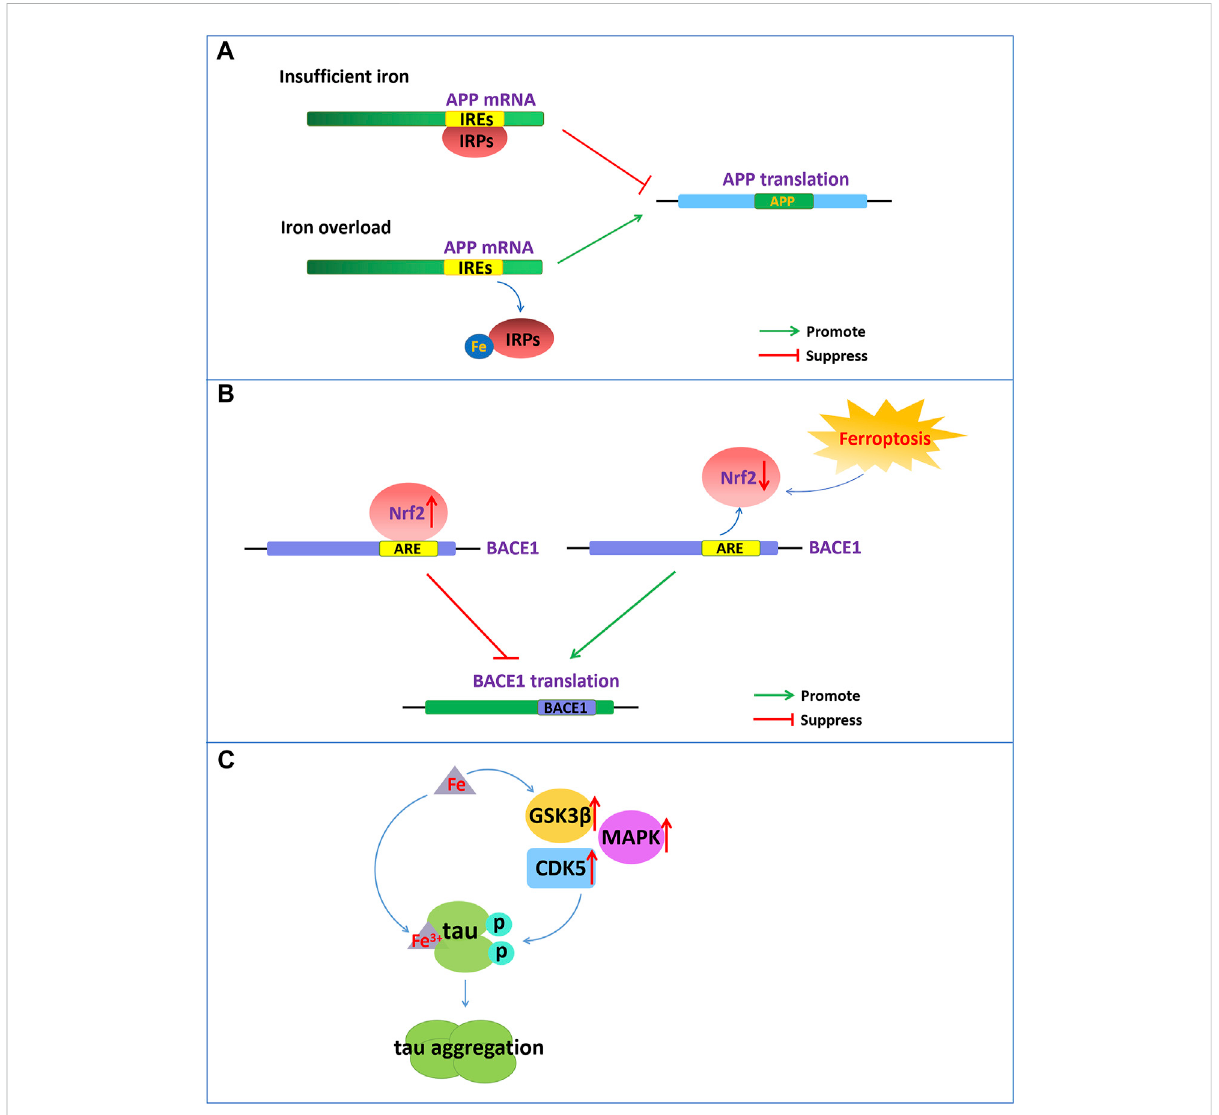
FIGURE 1 Irondyshomeostasiscontributetosenileplaquesdepositionandneuro fi brillarytangles. (A) The5 ′ -UTRofAPPmRNAcontainsIREs.APPcanbe posttranscriptionally regulated by IRP-IRE. Under conditions of insuf fi cient iron, IRPs bind to IREs of APP mRNA and repress APP translation. During iron overload, iron can bind to IRPs, leading to the dissociation of IRPs from IREs and promoting the translation of APP. (B) NRF2, as a negative regulator of BACE1, represses the expression of BACE1 by binding to AREs. Nrf2 activation repress BACE1 transcription. In turn, NRF2 inactivation promote BACE1 transcription. (C) Increased cellular iron levels promote the activity of enzymes such as GSK3 β , CDK5, and MAPK, which promote tau hyperphosphorylation. Fe3+ can promote the formation of tau fi brils by binding to the phosphorylated